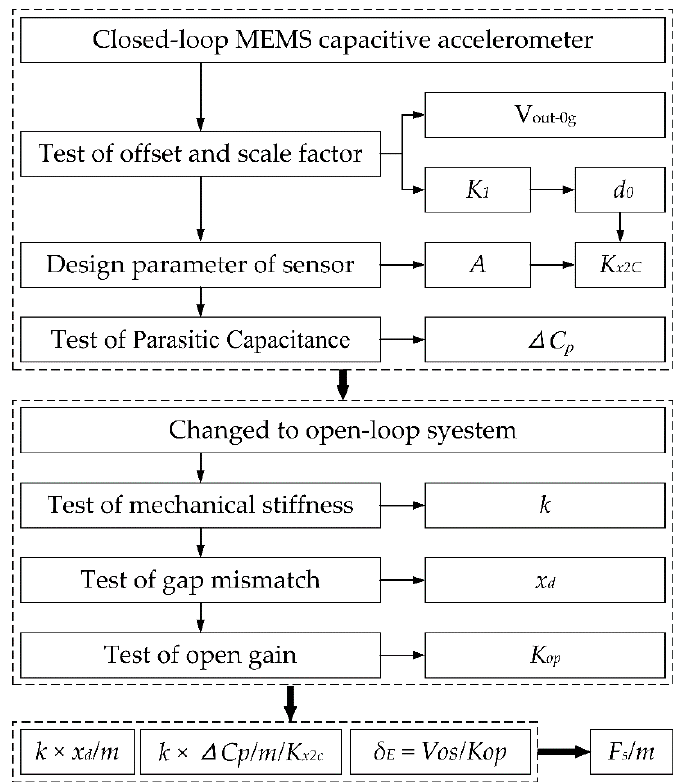
Figure 3. Procedure of decomposition method.